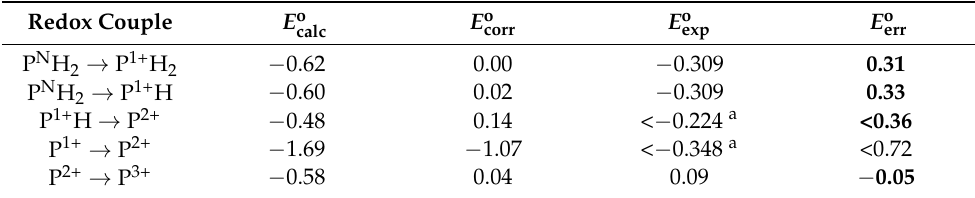
Table 2. Redox potentials of five redox couples for the P-cluster in V. E o is the raw redox potentials calc from the COSMO calculations, E o corr are calculated redox potentials corrected by the mean signed error + 0.62 V), E o (MSE = − 0.62 V) from our previous study [41] (i.e., E o corr = E o exp is the experimental calc redox potentials [5,24,25,45] and E o err is the error for the various calculations. Results with E o err < 0.44 V are marked in bold face. E o corr E o exp E o err Redox Couple E o calc P N H 2 → P 1+ H 2 − 0.62 0.00 − 0.309 0.31 P N H 2 → P 1+ H − 0.60 0.02 − 0.309 0.33 P 1+ H → P 2+ − 0.48 0.14 < − 0.224 a <0.36 P 1+ → P 2+ − 1.69 − 1.07 < − 0.348 a <0.72 P 2+ → P 3+ − 0.58 0.04 0.09 −